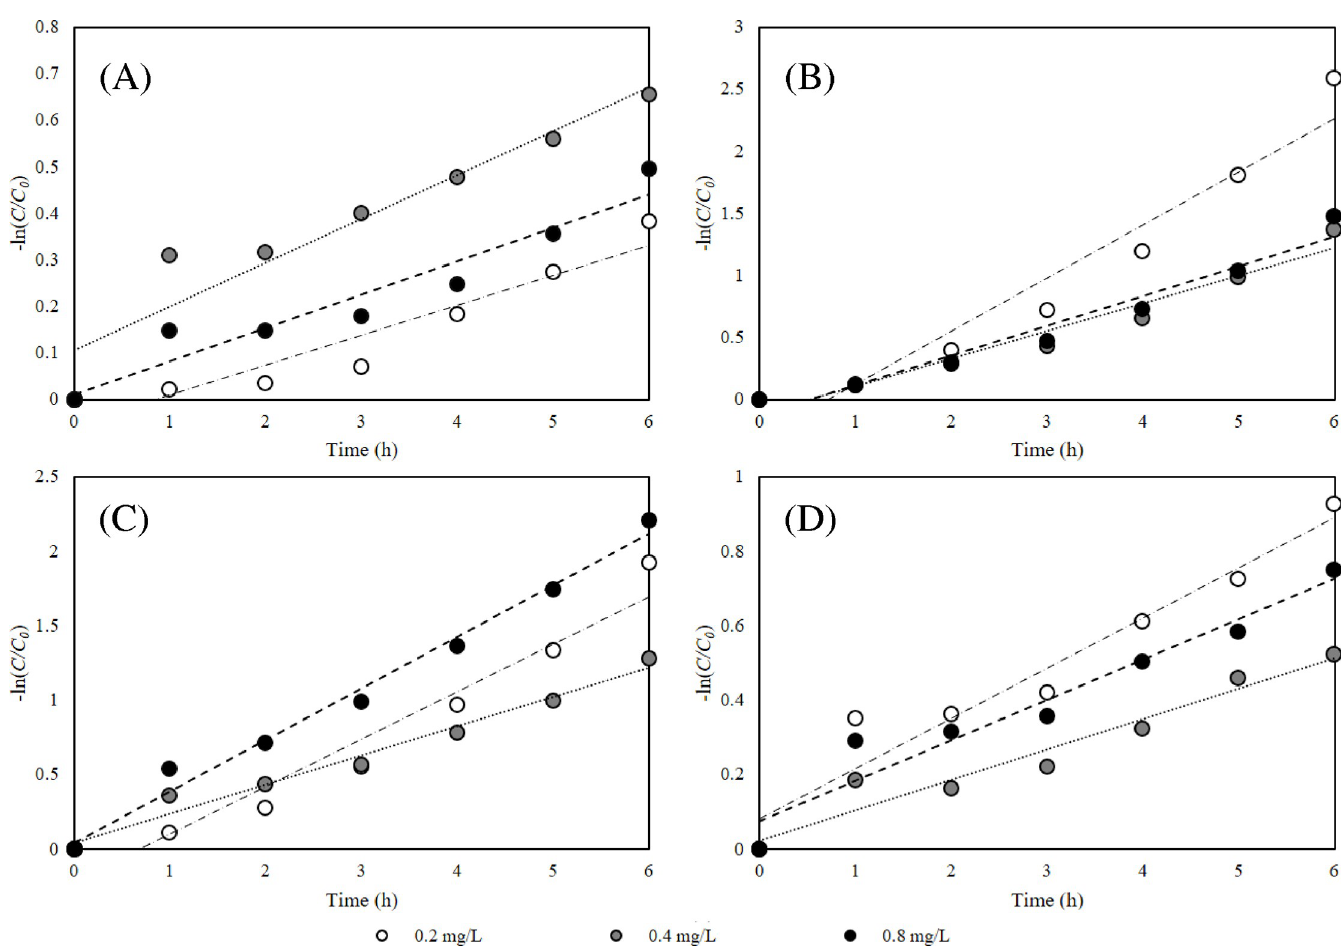
Fig 5. Impacts of initial magnetic-TiO 2 -nanocomposite concentration on R6G photodegradation kinetics. (A) Fe x O y /TiO 2 -0.5, (B) Fe x O y /TiO 2 -0.35, (C) Fe x O y @TiO 2 -0.5 and (D) Fe x O y @TiO 2 -0.35. Experimental conditions: UV-irradiation, 253 nm (20 W); initial R6G concentration, 10 mg/L; initial magnetic-TiO 2 - nanocomposites concentration, 0.2 mg/L, 0.4 mg/L and 0.8 mg/L, respectively; pH, 7.0.